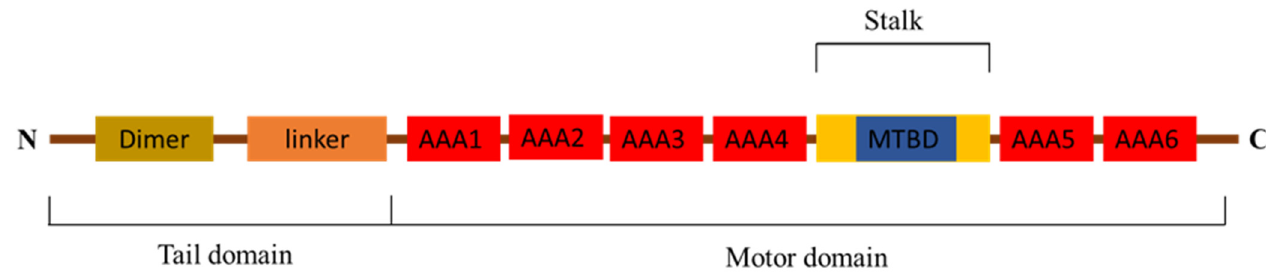
Figure 1. The protein structure domain of Pt -DHC. Pt -DHC divided into tail domain and motor domain, consisting of 6 AAA structures, MTBD, dimer and linker.